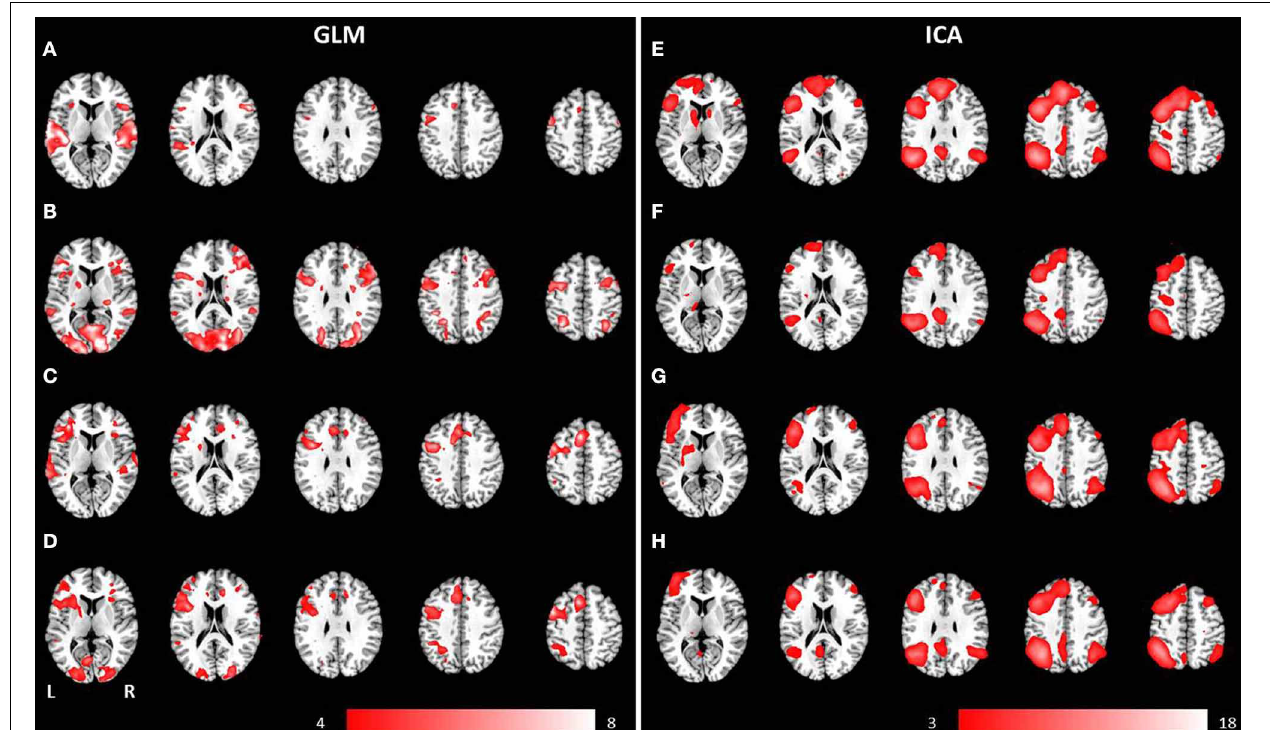
FIGURE 3 | Mean anatomical images overlaid with brain activation resulting from second-level GLM analysis and group ICA. Results